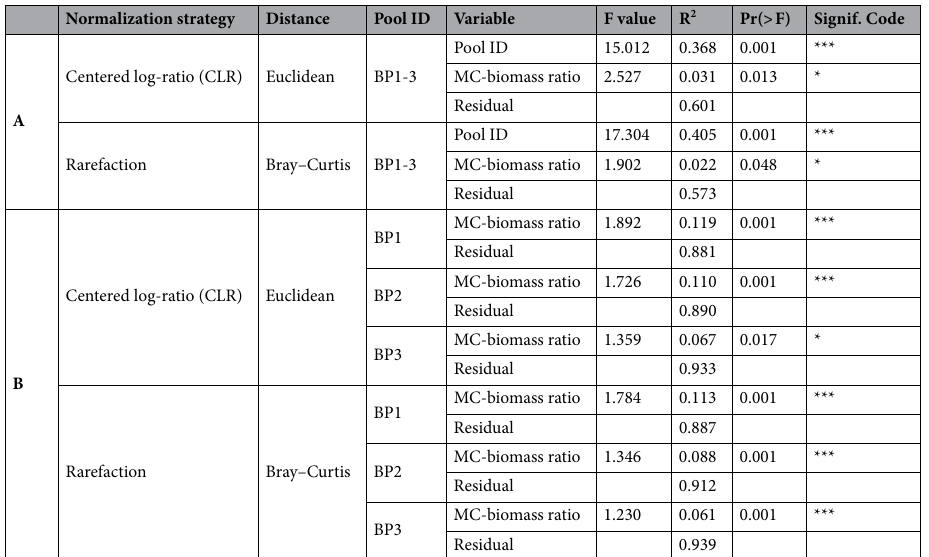
Table 2. Permutational multivariate analysis of variance (PERMANOVA) of beta diversity estimates showing the influence of Pool identifier (Pool ID: BP1, BP2, BP3), and the ratio between MC and Biomass (MC-biomass ratio) in explaining overall variance in microbial communities. Statistical tests were carried out on the entire dataset (A, Pool ID: BP1-BP3) and on individual pools (B).